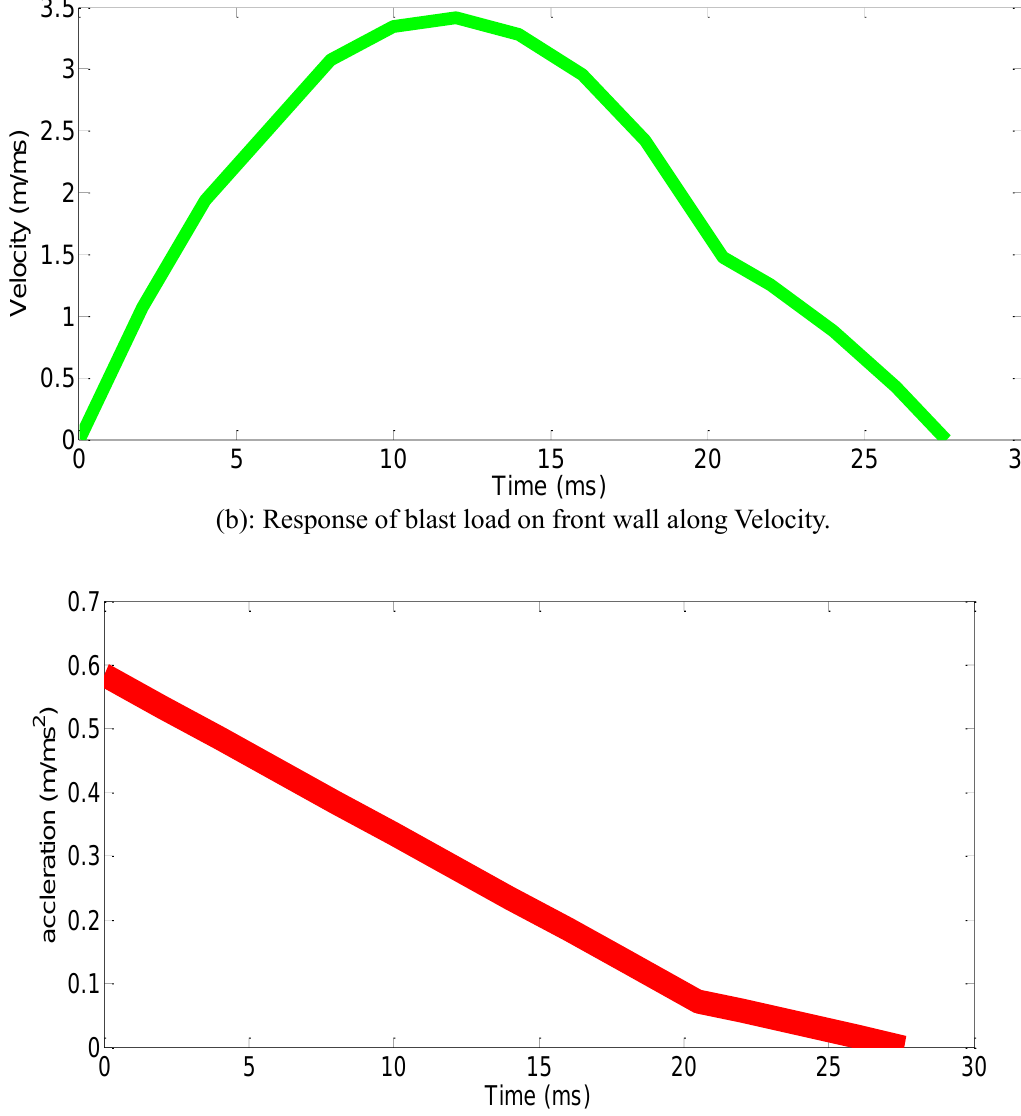
(c): Response of blast load on front wall along acceleration. Fig. 4. Response of blast load on front wall with respect to